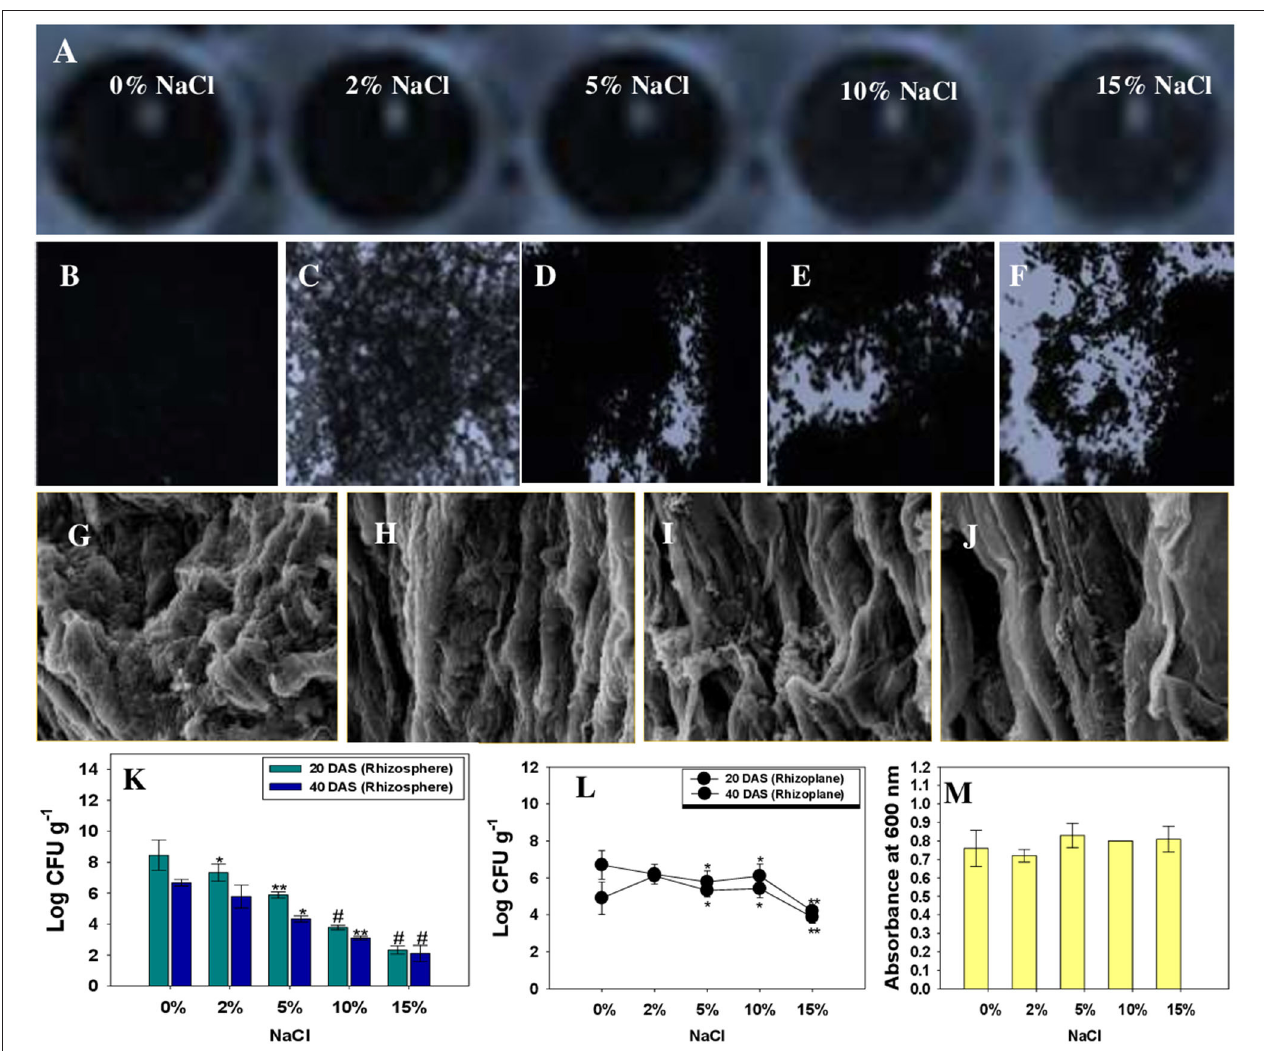
FIGURE 7 | In vitro biofilm formation by K. radicincitans co-cultivated with different levels of NaCl in polystyrene wells (A) and on A glass surface: control (B) , 2% NaCl (C) , 5% NaCl (D) , 10% NaCl (E) , and 15% NaCl (F) . Scanning electron micrographic images of R. sativus roots treated with different levels of NaCl and colonized by K. radicincitans (G–K) . (L,M) represent Log CFU of K. radicincitans g − 1 measured from radish rhizosphere (CFU g − 1 ) and rhizoplane (CFU g − 1 ), whereas (N) depicts the mean ± S.D. absorbance of in vitro biofilm by a crystal violet assay. The asterisks *, **, and # denote statistical significance at p < 0.05, p < 0.005, and p < 0.001,